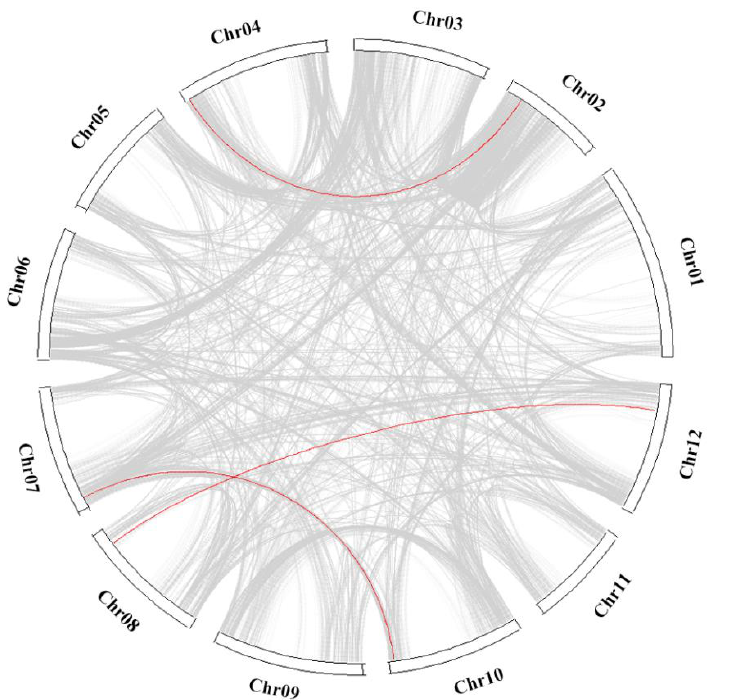
Figure 5. Collinearity analysis of the StMAPK and StMAPKK family.